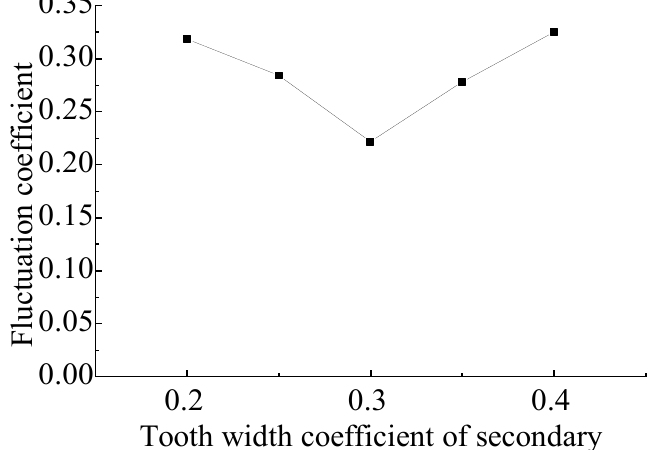
Figure 13. Relationship between electromagnetic force pulsation coefficients and the tooth width coefficient of the secondary tooth. Figure 14 shows the relationship between output power and efficiency with the height of the primary slot opening. It can be seen that the efficiency remains basically unchanged with the increase of the height of the primary slot opening, while the output power decreases with the increase of the height of the primary slot opening. Figure 15 shows the relationship between the fluctuation coefficient and the height of the primary slot opening. The fluctuation coefficient generally shows an upward trend with the height of the primary slot opening increasing. To sum up, the height of the primary slot opening is obtained by 6 mm.